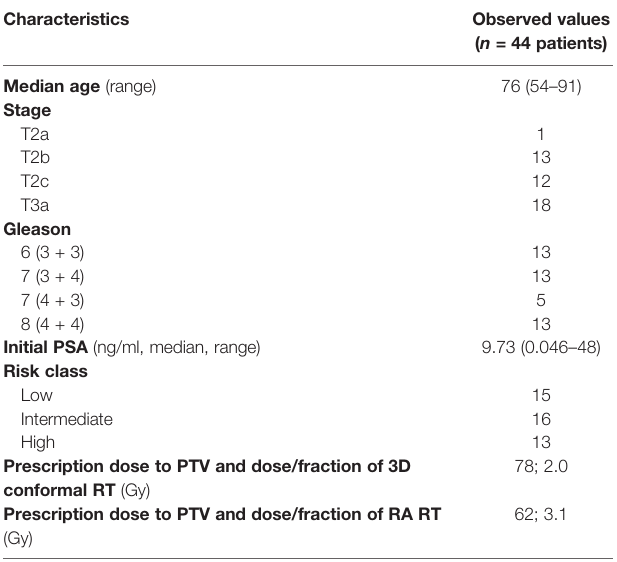
TABLE 1 | Patients ’